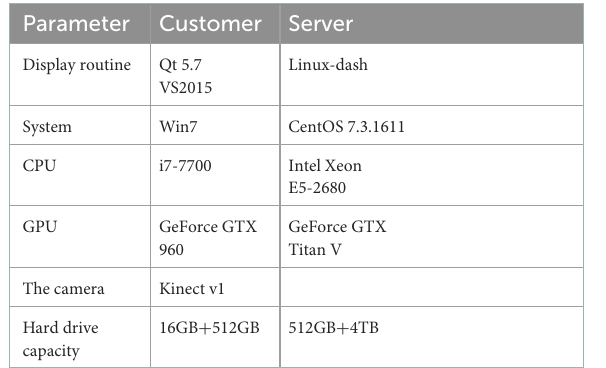
TABLE 1 Device configuration information.